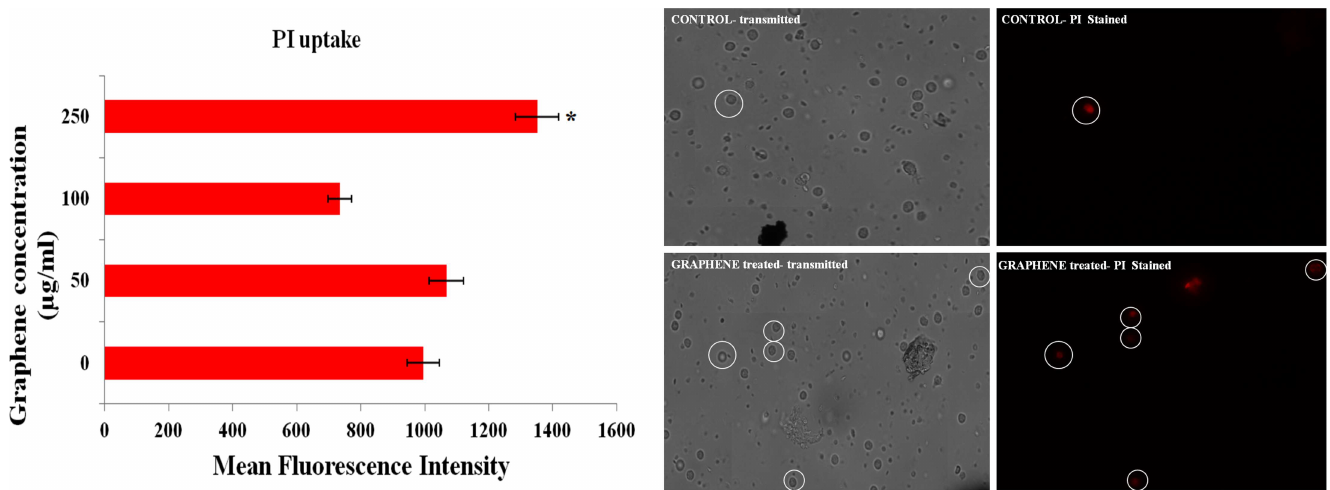
Fig 10. Flow cytometryand confocal microscopy of human PBMC treated with different concentrations of PR-GO.